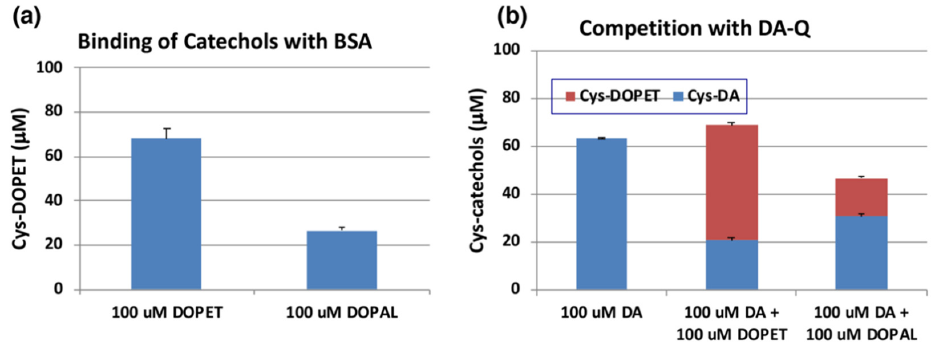
Figure 6. ( a ) Tyrosinase-catalyzed binding of DOPET and DOPAL (100 µ M) with BSA (300 µ M). ( b ) Competition of tyrosinase-catalyzed binding of DA (100 µ M) with DOPET or DOPAL (100 µ M). Mean ± SEM from three independent experiments ( a , b ).